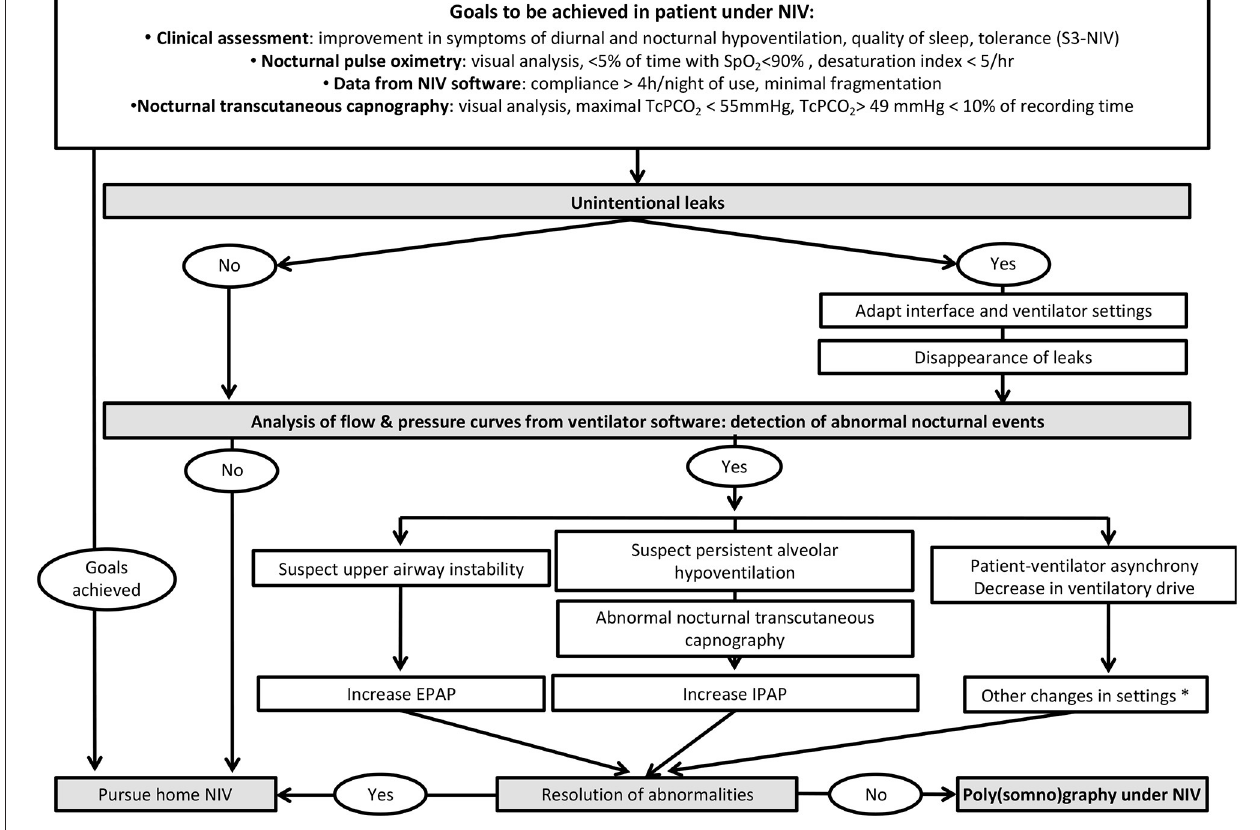
FIGURE 6 | Proposed algorithm for a systematic approach to monitoring of patients under LNIV and analysis of ventilator software. *: the reader is referred to references 4 and 8 for further